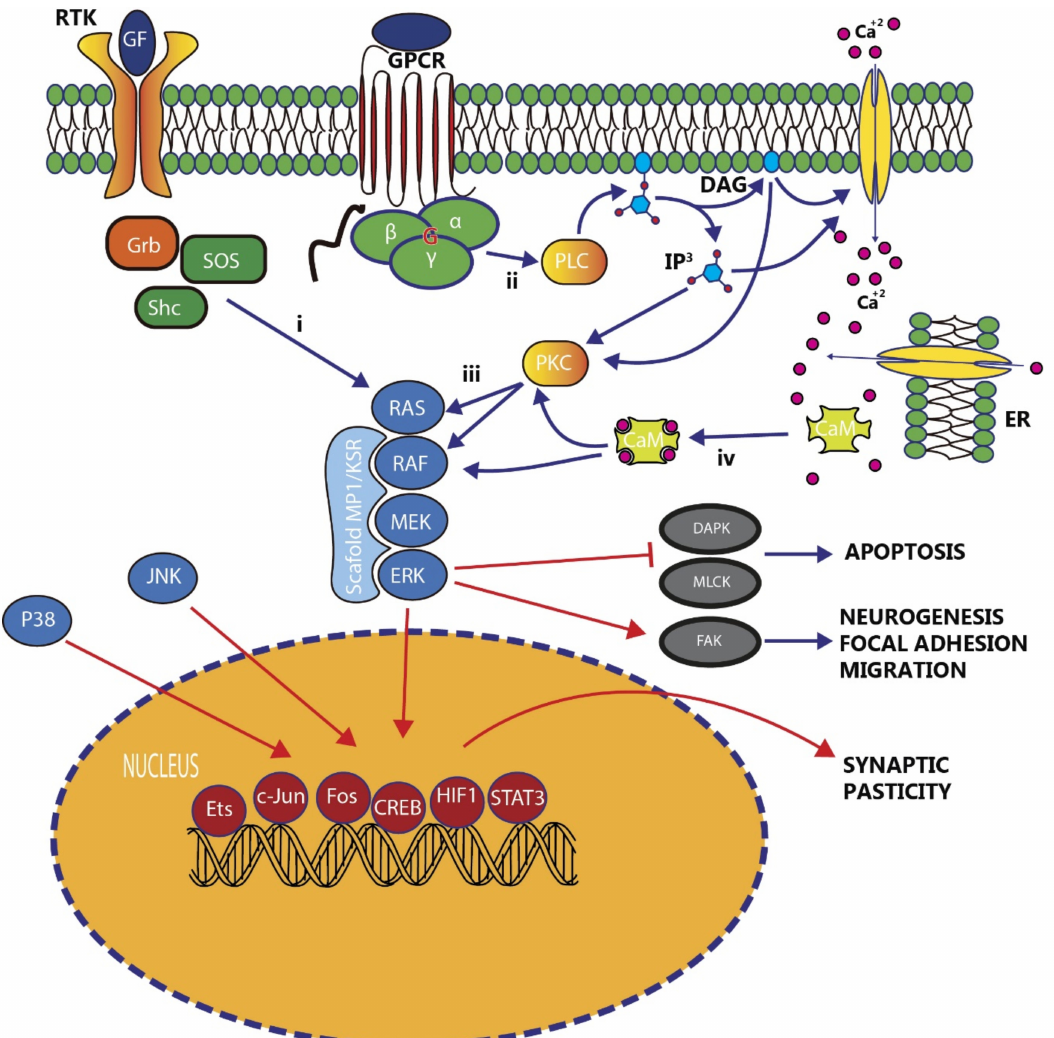
Figure 1. Schematic showing the main metabolic pathways in which MAPK / ERK signaling is involved. The ERK pathway can be activated by two main receptors, i.e., receptor tyrosine kinase (RTK) (i) and G-protein coupled receptor (GPCR) (ii). In addition, cytosolic mechanisms can also activate the pathway through protein kinase C (PKC) (iii) or calcium-calmodulin (CaM) (iv). The activation of the pathway can be directed by sca ff olding proteins that hold together the components of the pathway. Once ERK is phosphorylated, cytoplasmic or nuclear changes may be induced, activating sets of genes responsible for neural di ff erentiation, migration, the final fate, and plastic changes. Cytoplasmic p-ERK can promote processes such as apoptosis and